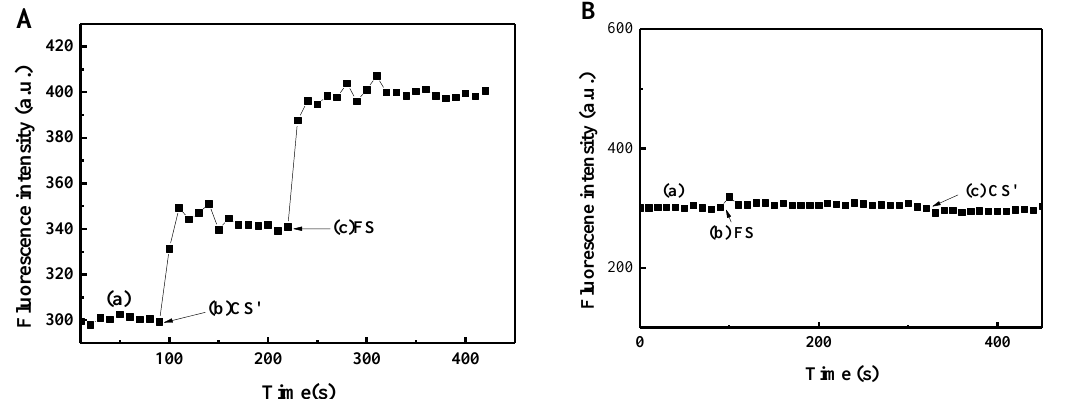
Figure 2. Time detection of the reaction process: ( A ) (a) DNA probe, GO, PicoGreen, and 500 nM ATP; (b) CS' DNA; (c) FS DNA. ( B ) (a) DNA probe, GO, PicoGreen; (b) FS DNA; (c) CS' DNA.